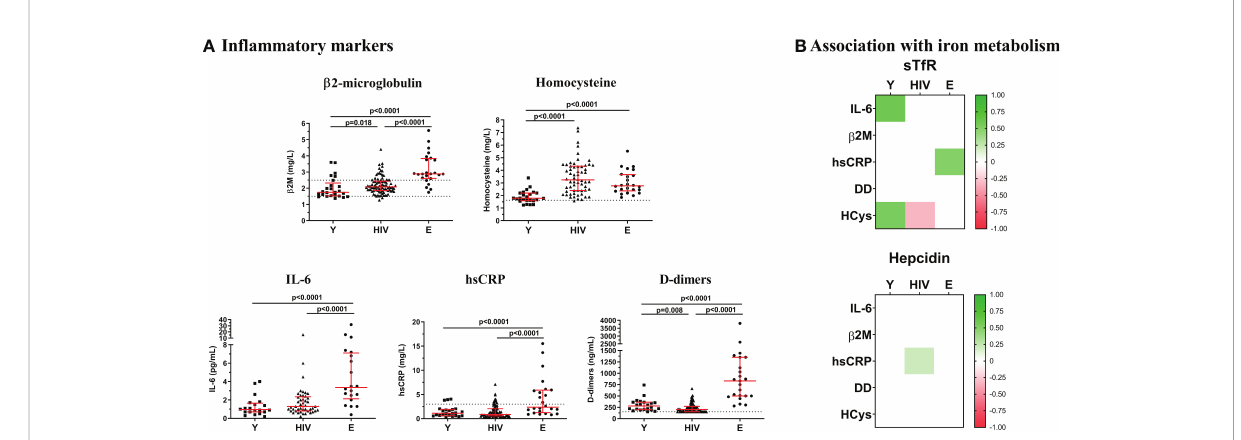
FIGURE 2 In fl ammatory markers. (A) Levels of Β 2-microglobulin, homocysteine, IL-6, hsCRP, and D-dimers were quanti fi ed in Young non-HIV (Y), HIV, and Elderly non-HIV (E) groups. Comparisons were assessed using nonparametric Kruskal-Wallis/Mann – Whitney U tests. Variables with a p - value <0.05 were considered statistically signi fi cant. Grid lines represent minimum and maximum standard values. (B) Associations between sTfR or hepcidin and in fl ammatory markers in Y, HIV and E groups. Color intensity boxes represents Spearman ’ s rank coef fi cient value as indicated in the color legend. All colored boxes represent statistically signi fi cant correlations. White boxes represent correlations with p -values >0.05. IL-6, interleukin 6; Β 2M, Β 2-microglobulin; hsCRP, high sensitive C reactive protein; DD, D-dimers; HCys,